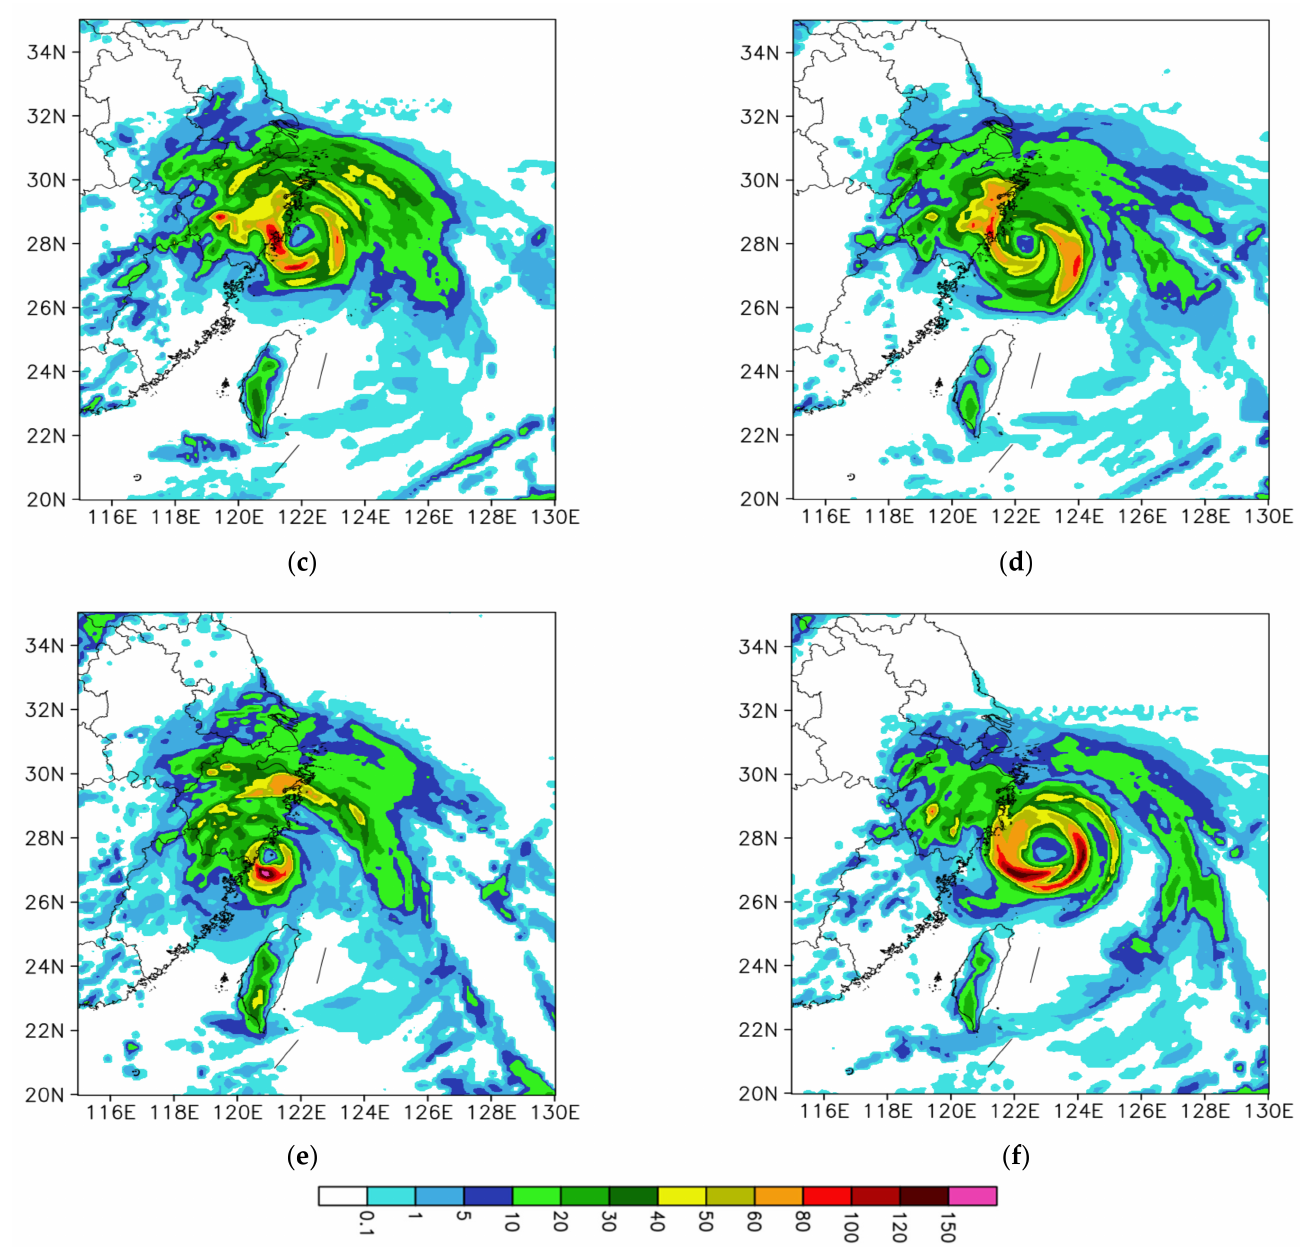
Figure 16. ( a ) The observed total accumulated rainfall (mm) after landfall from 0200 UTC to 0500 UTC 10 August 2019 and the corresponding forecast rainfall of the five experiments: ( b ) CDA-3, ( c ) CDA-2, ( d ) CDA-1, ( e ) SDA, and ( f )